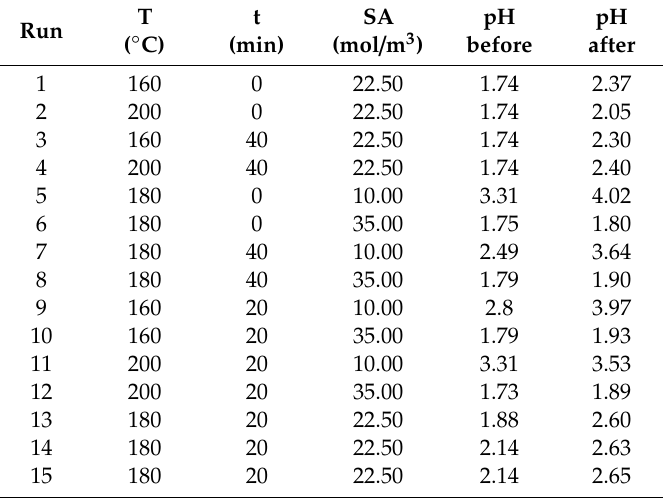
Table 1. Box–Behnken experimental